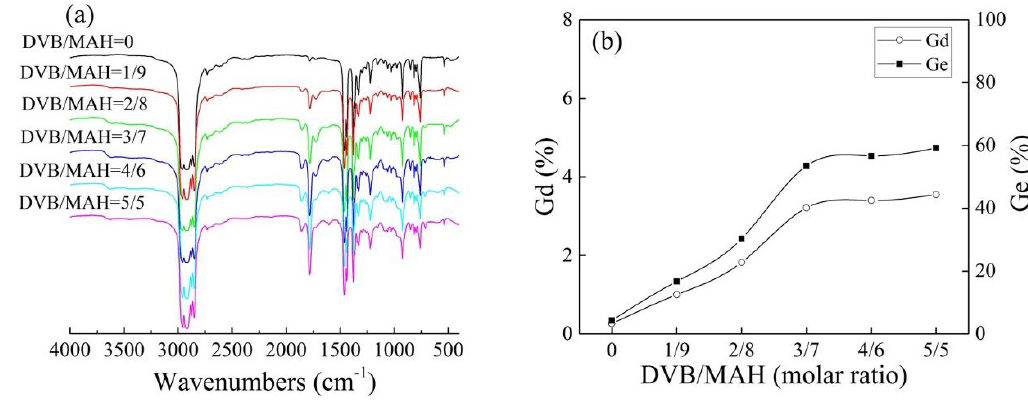
Figure 2. FTIR spectra ( a ) and Gd/Ge ( b ) of grafted products at different DVB concentrations.